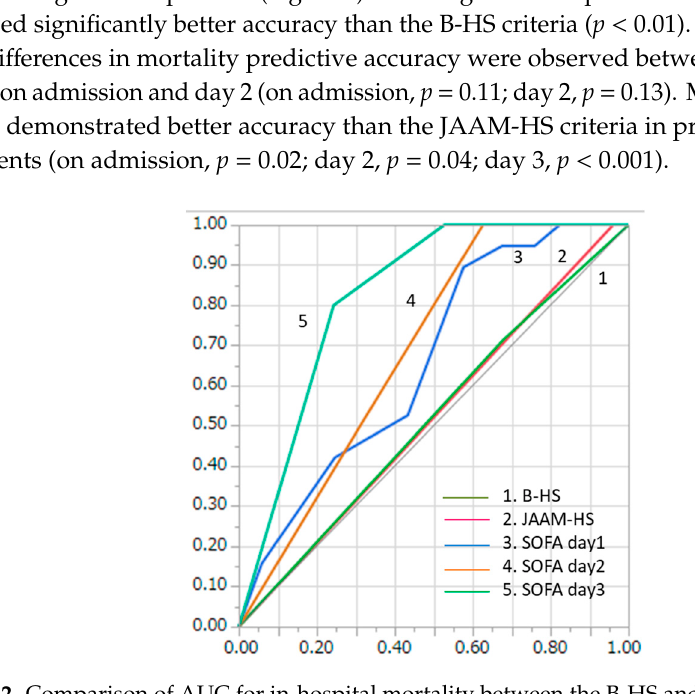
Table 4. Prediction of mortality among the B-HS and JAAM-HS patients.